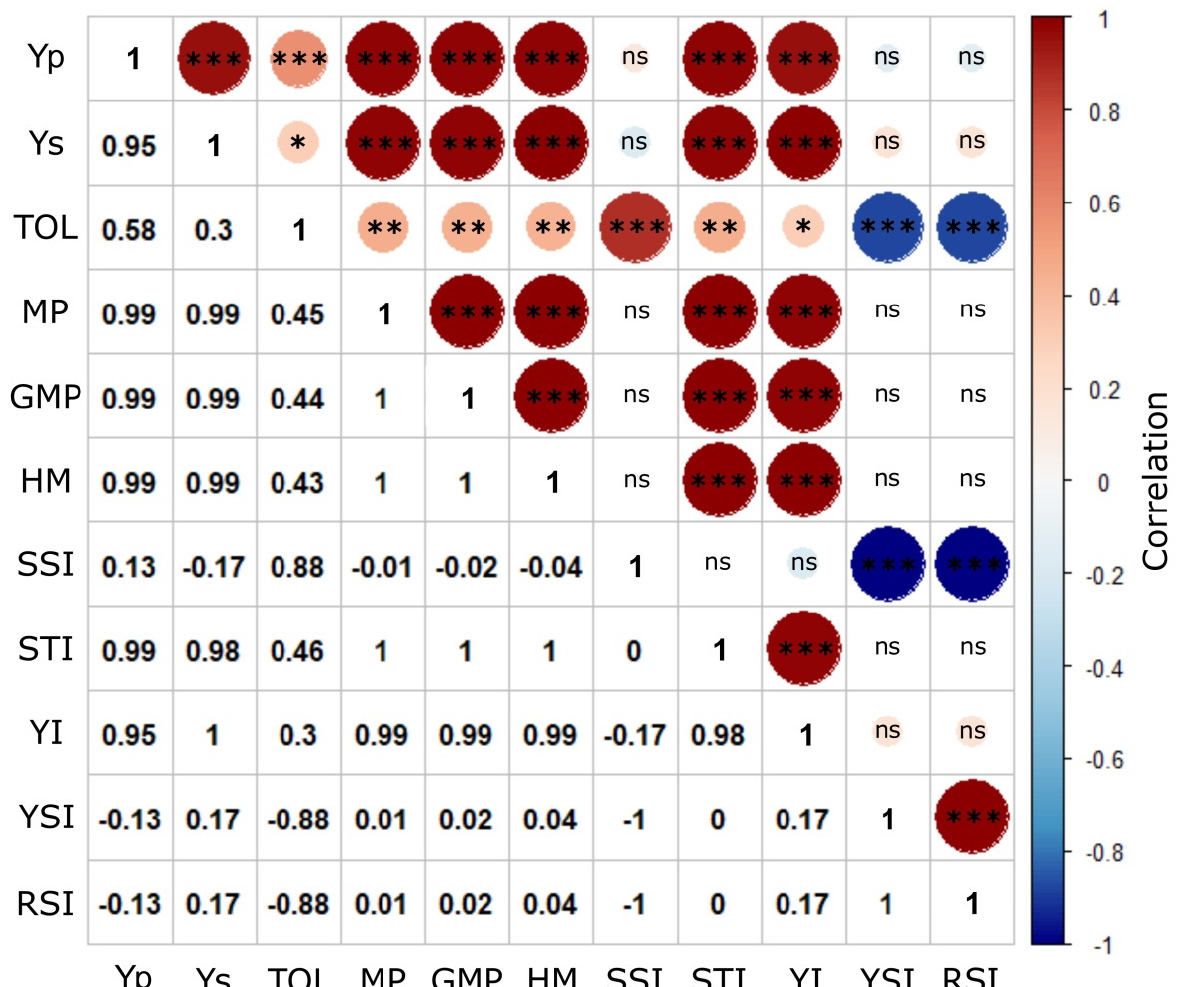
Figure 2. Correlation coefficients (r) and correlogram for the grain protein content and stress screening indices. ns—not significant, *, ** and ***—significant at the level of probability p < 0.05, 0.01 and 0.001, respectively.